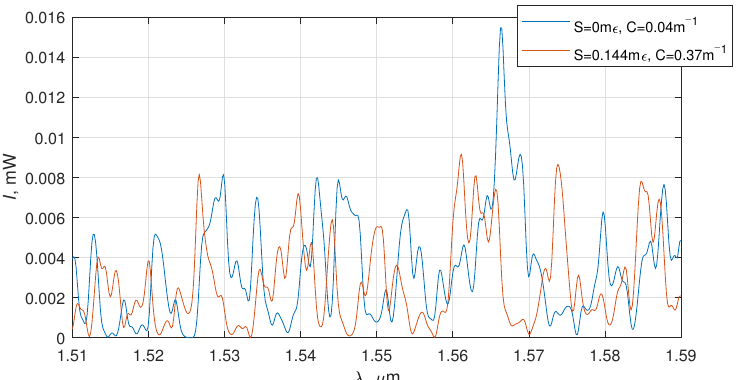
Figure 5. Spectral interference signals of intermode interferometer in cases of different perturbations applied to the sensing MM section.